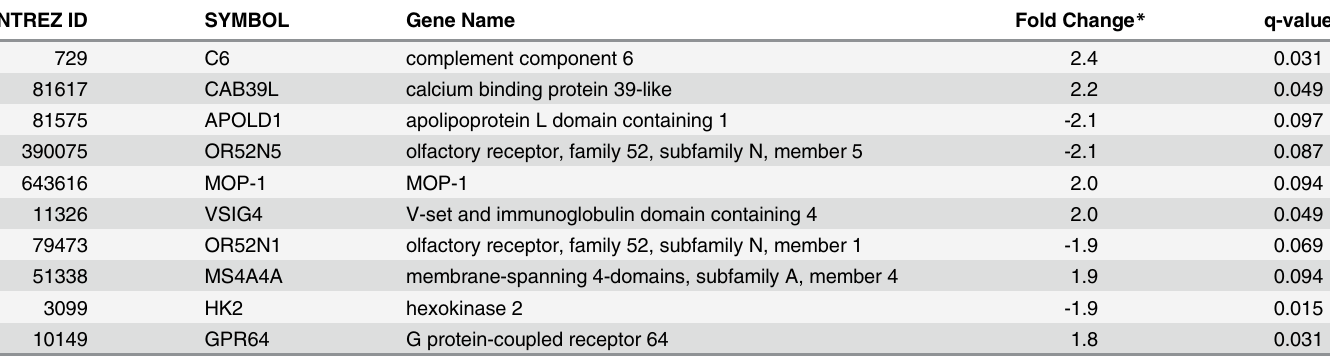
Table 7. A list of the 10 differentially expressed transcripts in the subcutaneous adipose tissues between the pregnant and non-pregnant